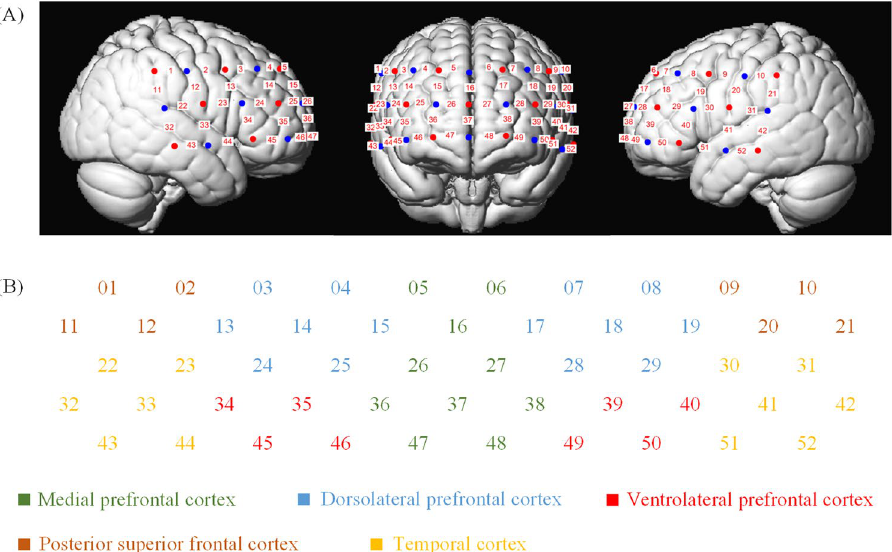
Figure 5. Schematic arrangement of the fNIRS probe array. ( A ) Location of optodes (red = emitters; blue = detectors) and channels (numbers) over a standard brain model. ( B ) Anatomical areas covered by the probe array. Different colors represent different anatomical